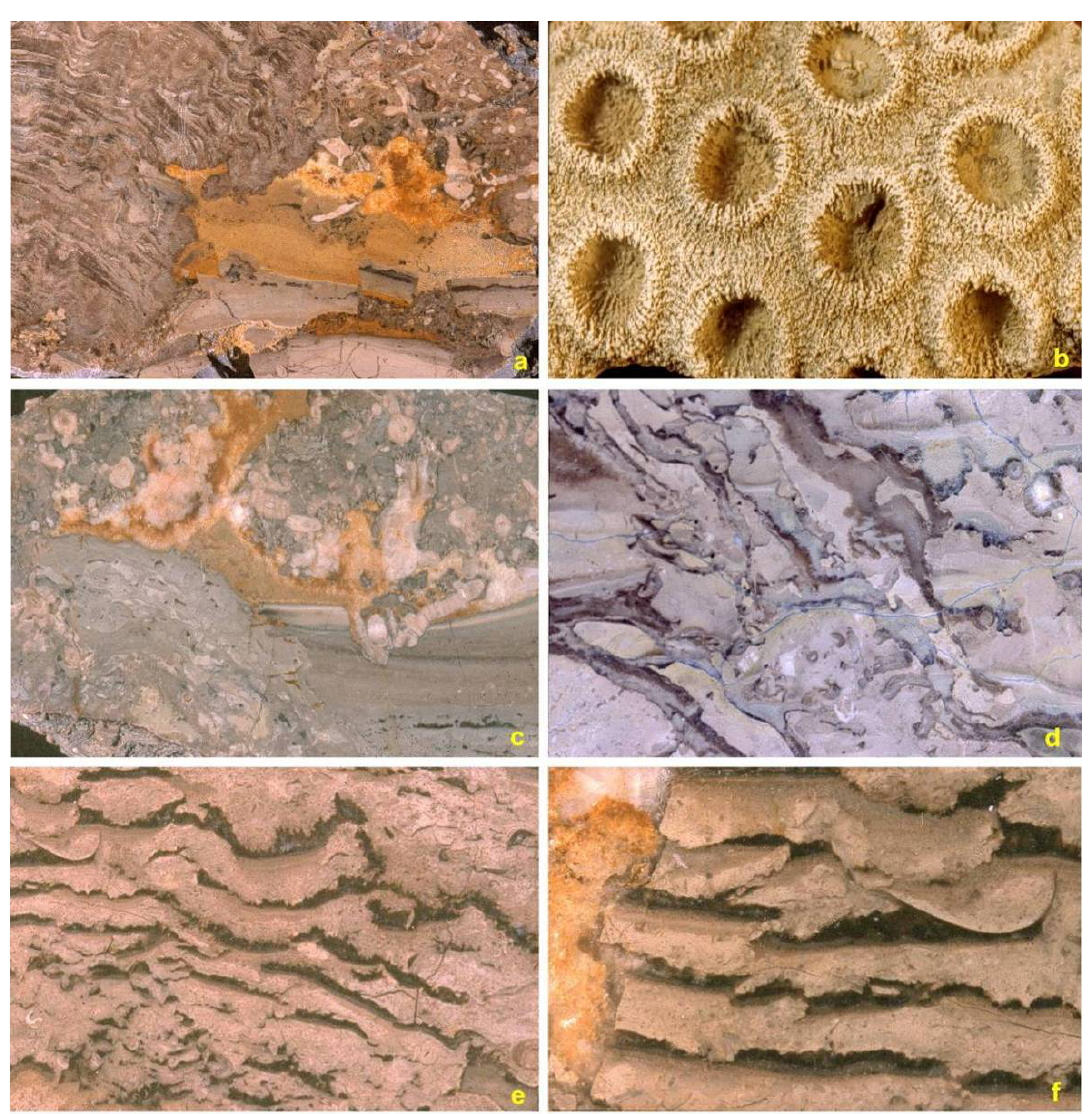
Figure 8. Reef core cavity formation, infill and “stromatactis” structures from polished slabs. ( a ) longitudinal polished slab view of the rugose coral Palaearaea forming an adjacent cavity with cavity sediment fill (right side, width of field = 25 cm); ( b ) aphroid Palaearaea , a major reef former, in surface view (scale bar = 1 mm; colony width = 15 cm, GSC125361); ( c ) reef cavity formed by calcimicrobial mound growth of Wetheredella, Girvanella and Rothpletzella (lower left side), followed by crinoid holdfasts forming a “roof”, and then successive cavity infill by sand to silt to mud-sized sediment, and remaining empty space filled by post-depositional; cement (upper left; width of slab = 15 cm); ( d ) basal reef core cavity infill and formation-crinoids and syringoporid formed the cavity space, repeatedly broken by storm action and re-infilled over several seasons; ( e ) and ( f ) “stromatactis” cavity fill structures in reef core marking successive infill by silt to mud-sized carbonate sediment, early cementation forming a roof to the cavity (later infilled by sparry calcite) and probable seasonal cycles, ( e , width = 15 cm; f , width = 5 cm); ( g ) irregular “stromatactis” formed by roofed over Paleofavosites and successive cavity infills and sparry cement (width of slab = 5 cm); ( h ) irregular ‘stromatactis’ cavity infill underneath alveolitid